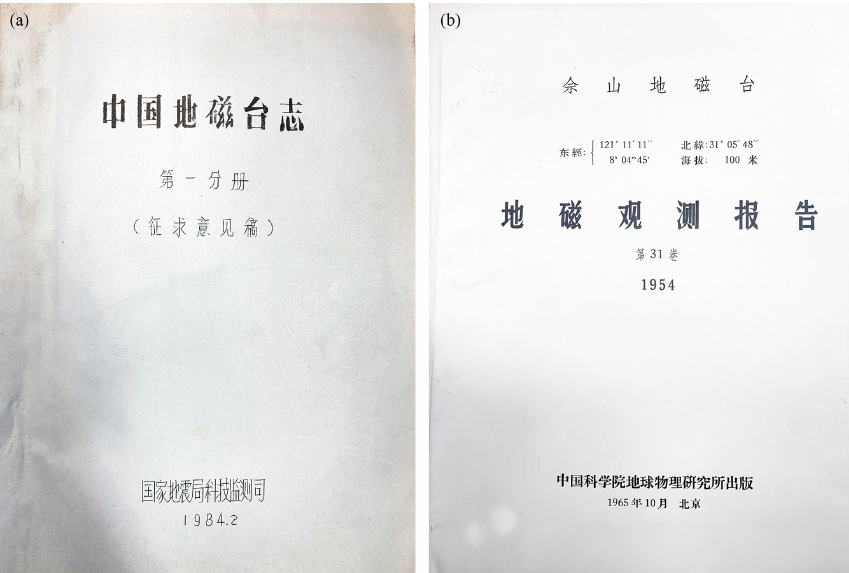
Figure 1. Cover of the (a) Chronicles of China Geomagnetic Observatory (Department of Science, Technology and Monitoring, CEA, 1984) and (b) Geomagnetic Observation Report (Institute of Geophysics, Chinese Academy of Sciences, 1965).